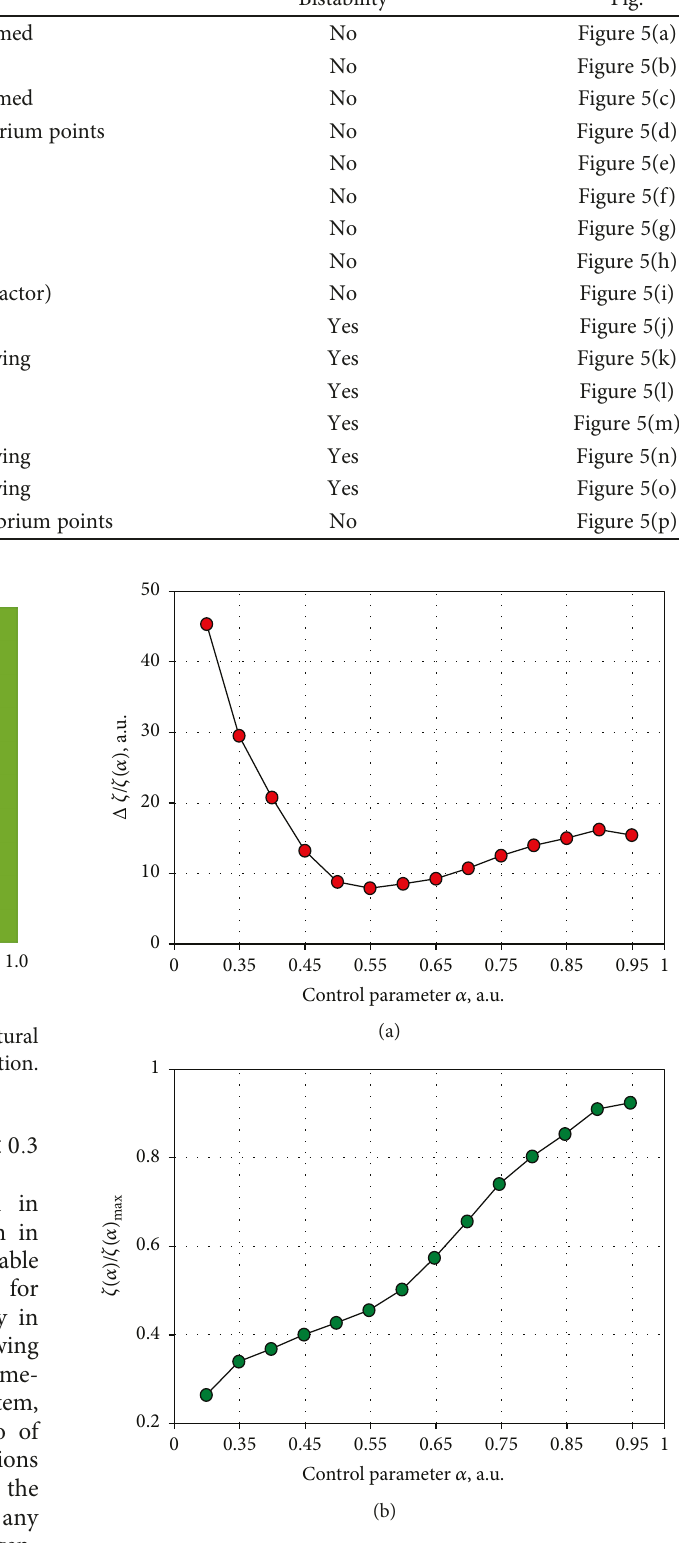
Figure 7: (a) Ration curve of the 9-scroll operation zone and (b) normalized operation zone for every dynamical